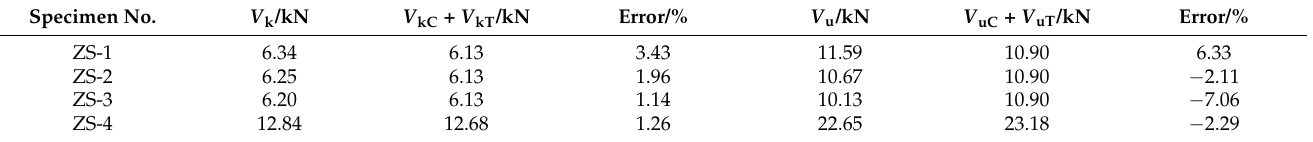
Table 6. Errors of shear bearing capacity between combined specimens and single connector.